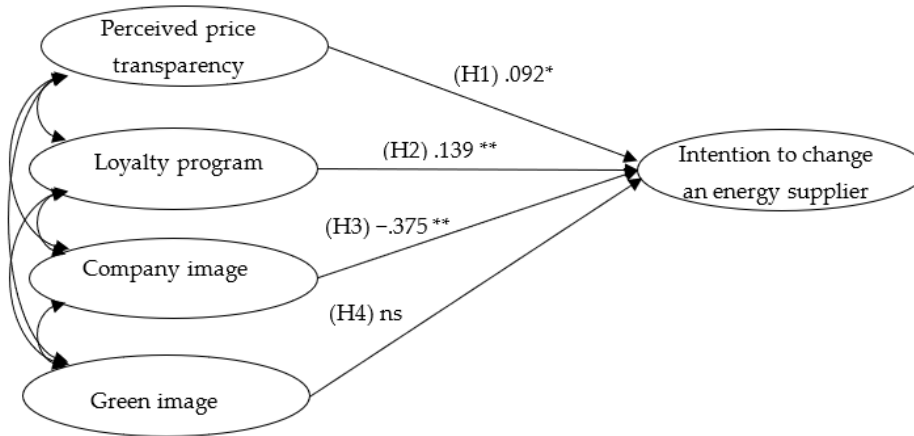
Figure 2. Summary of the research results (total research group). Note: ** p < .001; * p < .05, ns—nonsignificant. Table 4. Verification of research hypotheses (total research group).